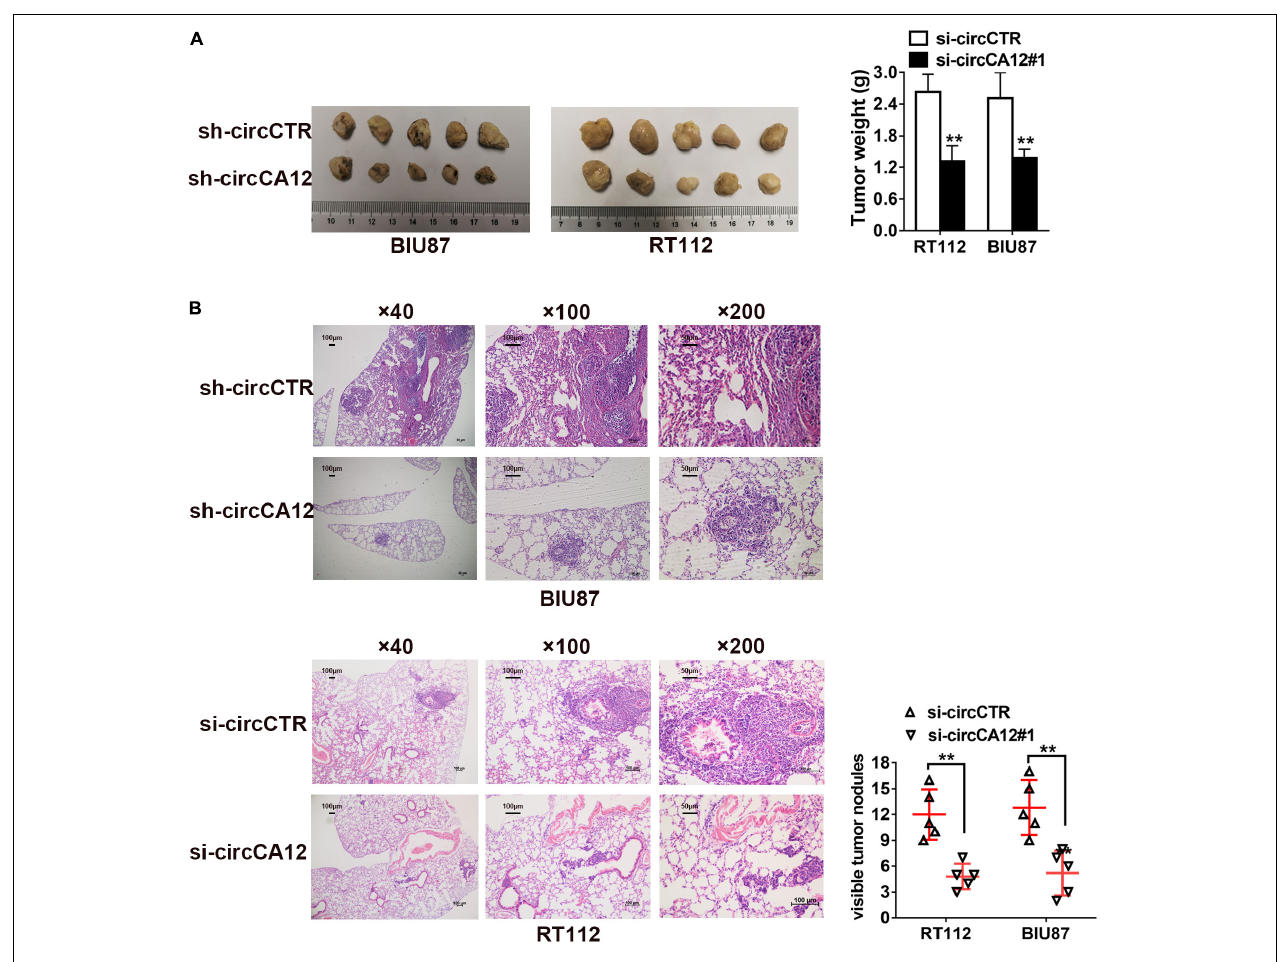
FIGURE 3 | Knockdown of circCA12 represses the proliferation along with metastasis of bladder cancer in vivo . (A) Mice xenograft models were constructed using RT-112 and BIU-87 cell lines. The weight of tumors was measured after 28 days. (B) Lung metastases HE staining images illustrating metastatic nodule numbers in the lung. ** P <